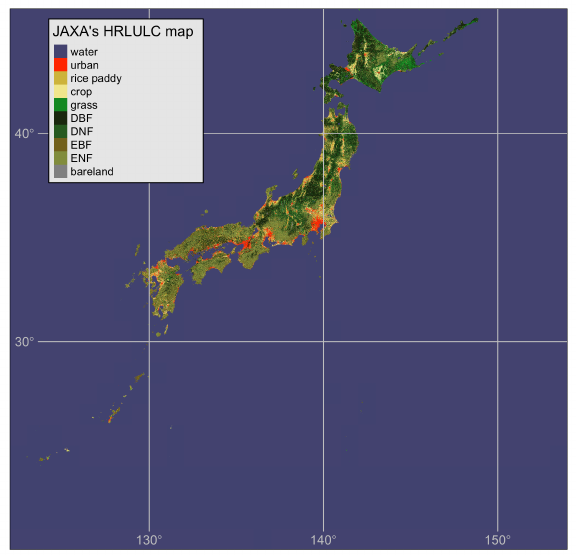
Figure 1. JAXA’s land use land cover